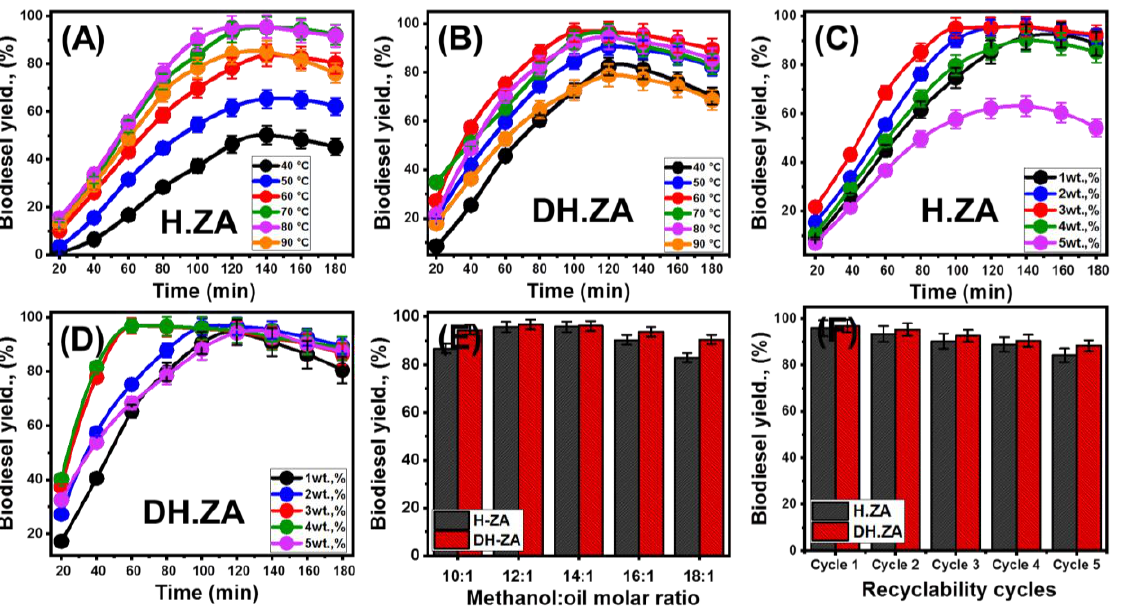
Figure 4. shows the effect of the transesterification at different temperatures on the biodiesel yield obtained by H.ZA and DH.ZA ( A , B ), the effect of the transesterification using different loads of H.ZA and DH.ZA on the obtained biodiesel yield ( C , D ), the effect of the methanol-to-oil molar ra- tio on the obtained biodiesel yield by H.ZA and DH.ZA ( E ), and the recyclability properties of H.ZA and DH.ZA during the transesterification of waste cooking oil ( F ).